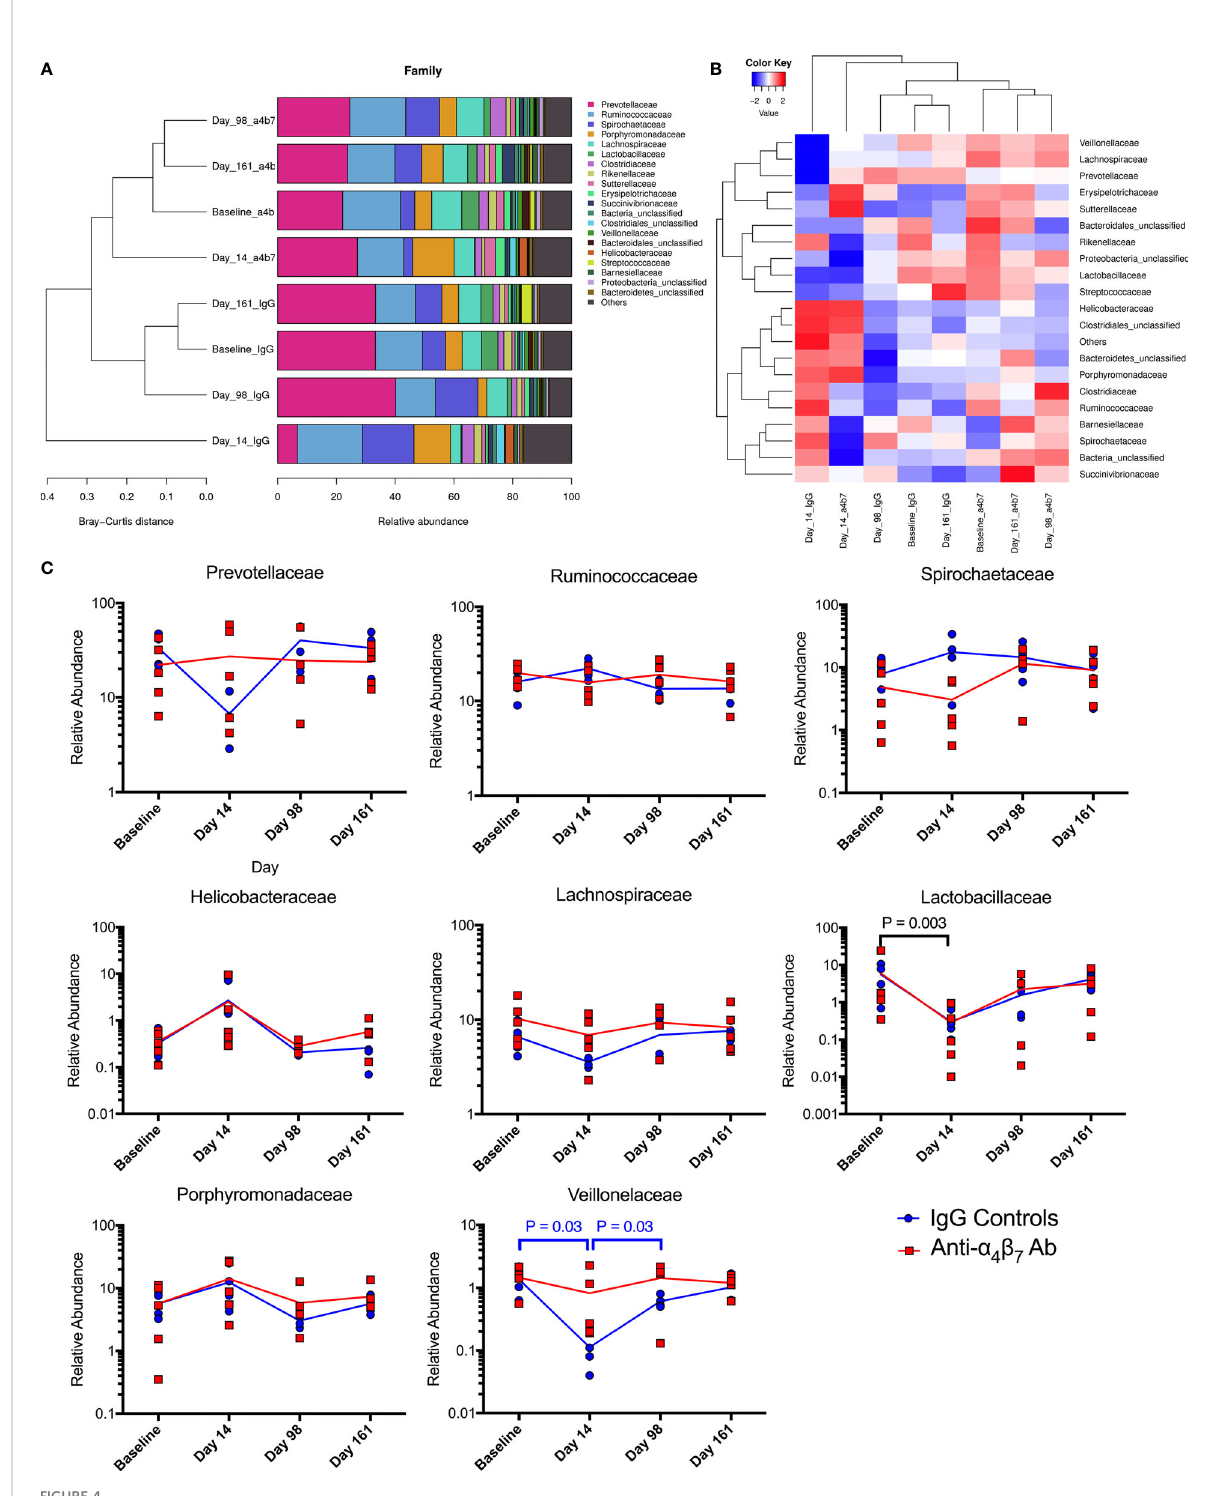
FIGURE 4 Microbiome family composition is disrupted by acute SIV infection: Both (A) stacked grouped abundance and (B) heatmap demonstrate acute dysbiosis at Day 14 post-infection where family relative abundance does not group within experimental groups. (C) Longitudinal changes to family abundance of Prevotellaceae, Ruminococcaceae, Porphyromonadaceae, Spirochaetaceae, Lachnospiraceae, Lactobacillaceae, Helicobacteraceae, and